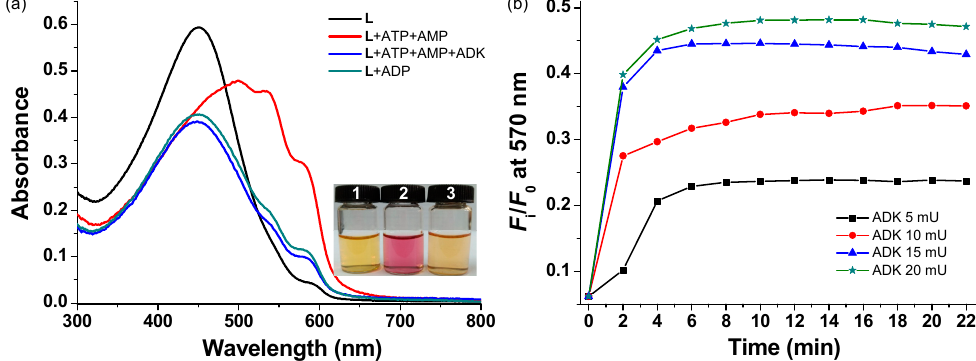
Figure 6. ( a ) Absorption spectra of L before and after incubating with ADK in buffer solution. Inset: The photographs taken from L (1) and L/ATP/AMP before (2) and after (3) incubating with ADK. ( L ) = 50 μ M, (ATP) = (AMP) = 20 μ M, (ADP) = 40 μ M, (ADK) = 100 mU/mL. Incubating time was 15 min; ( b ) Time-trace plots of the conversion from ATP and AMP to ADP catalyzed by various concentration of ADK (5–20 mU/mL) monitored by the emission ratio F i / F 0 . ( L ) = 10 μ M, (ATP) = (AMP) = 2 μ M. Excitation wavelength: 450 nm. All measurements were performed in tris -HCl buffer solution (10 mM, pH 7.4) containing 0.2 mM Mg 2+ ions.